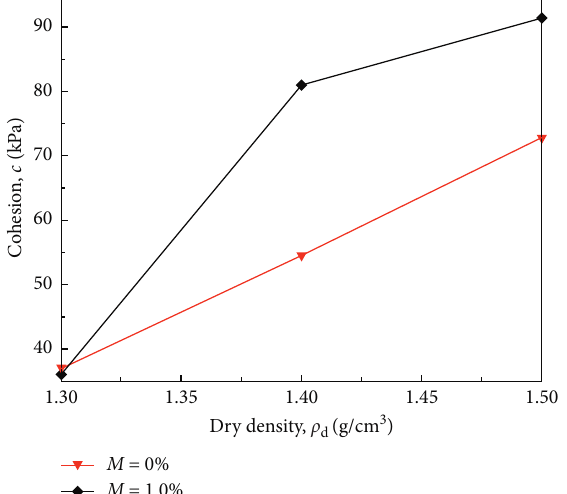
Figure 10: Effect of dry density on internal friction angle.